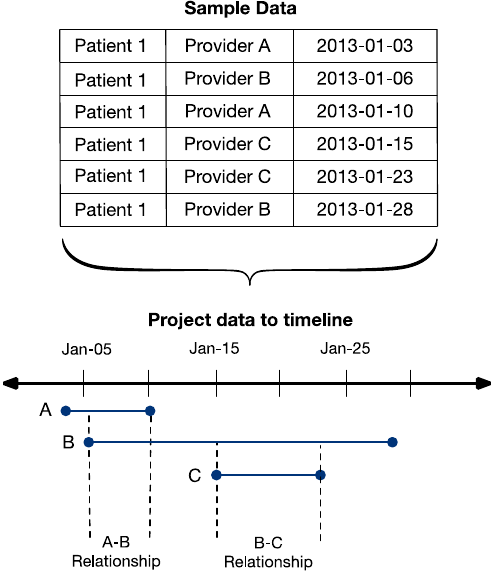
Figure 1. Temporal edge creation.